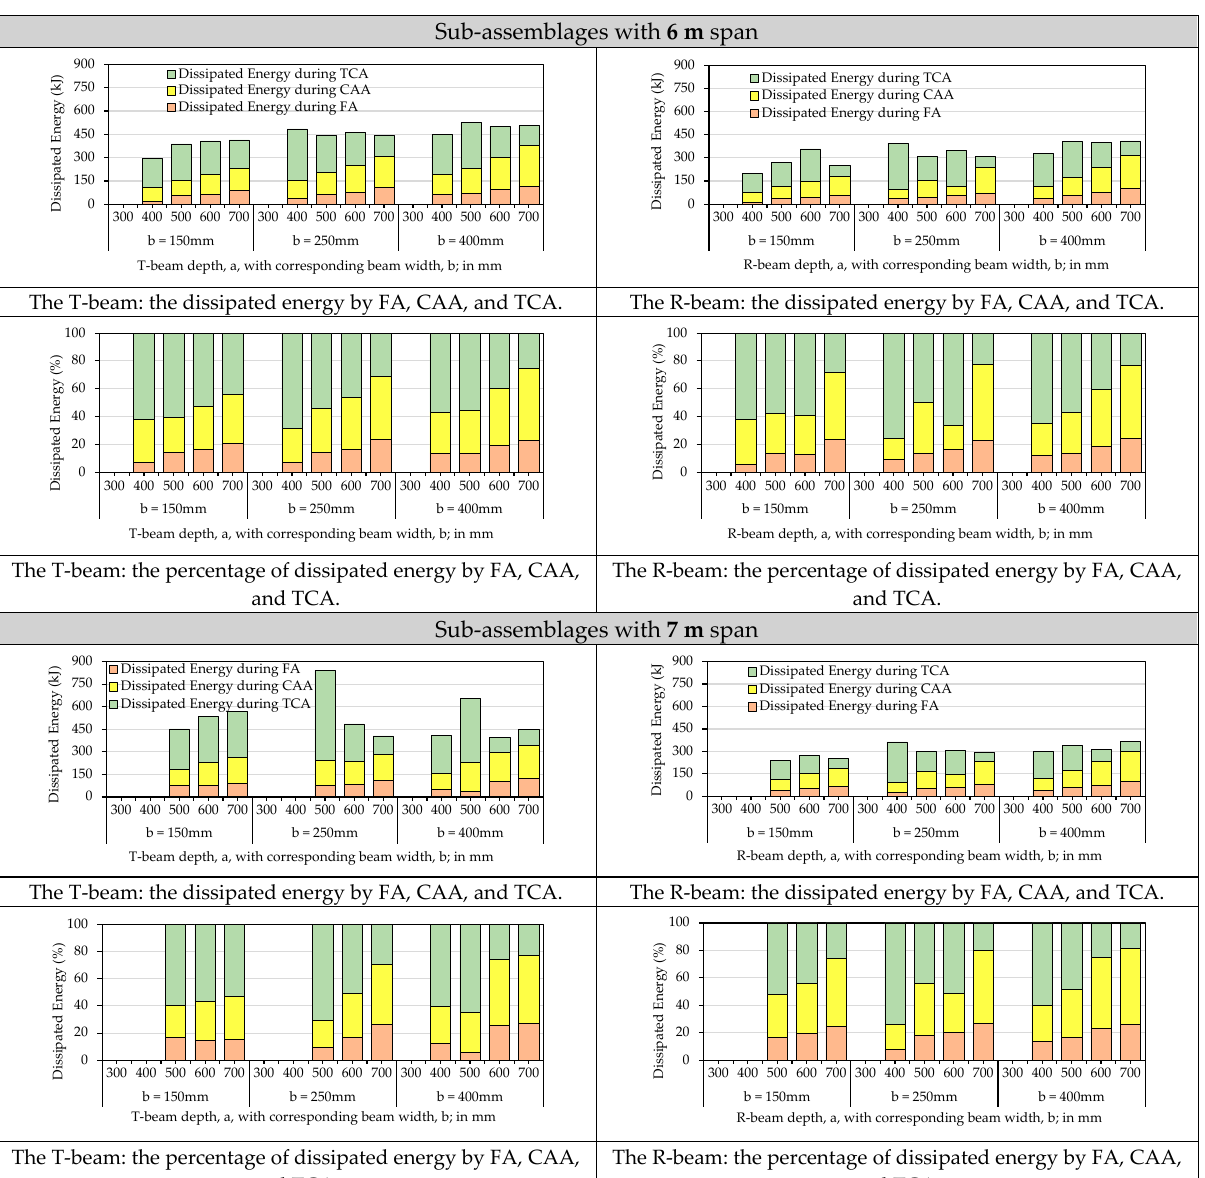
and TCA. Figure 7. The energy dissipated by the sub-assemblage varying design options and spans.